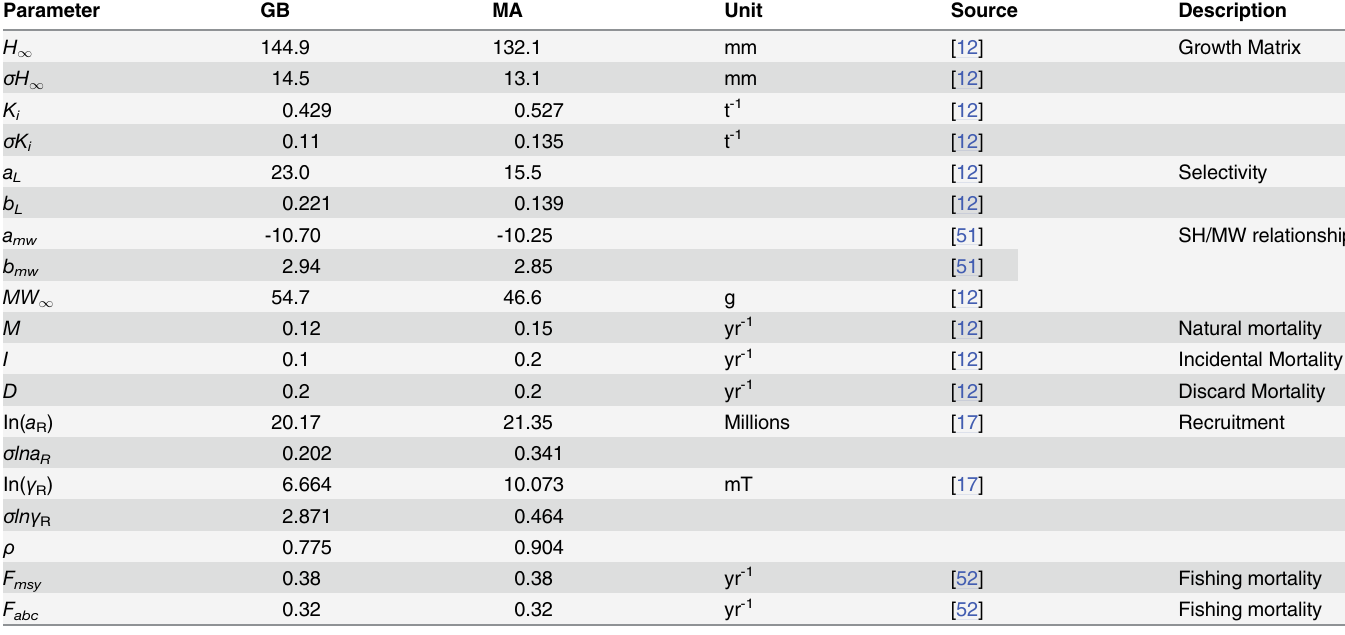
Items, except for discard mortality rates, have different values for Georges Bank (GB) and Mid Atlantic (MA).